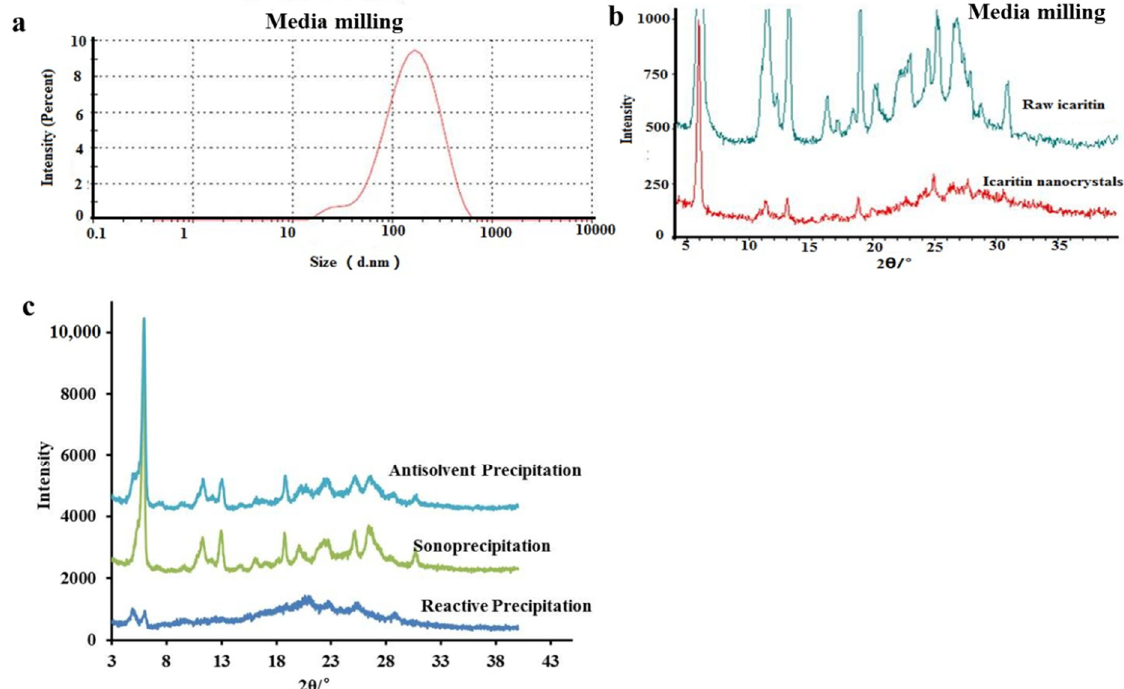
Figure 6. PSD and XRPD patterns of icaritin nanocrystals prepared by media milling ( a , b ), and XRPD patterns of AINs prepared using three other preparation methods ( c ). AINs: amorphous icaritin nanoparticles; PSD: particle size distribution; XRPD: X-ray powder diffraction.